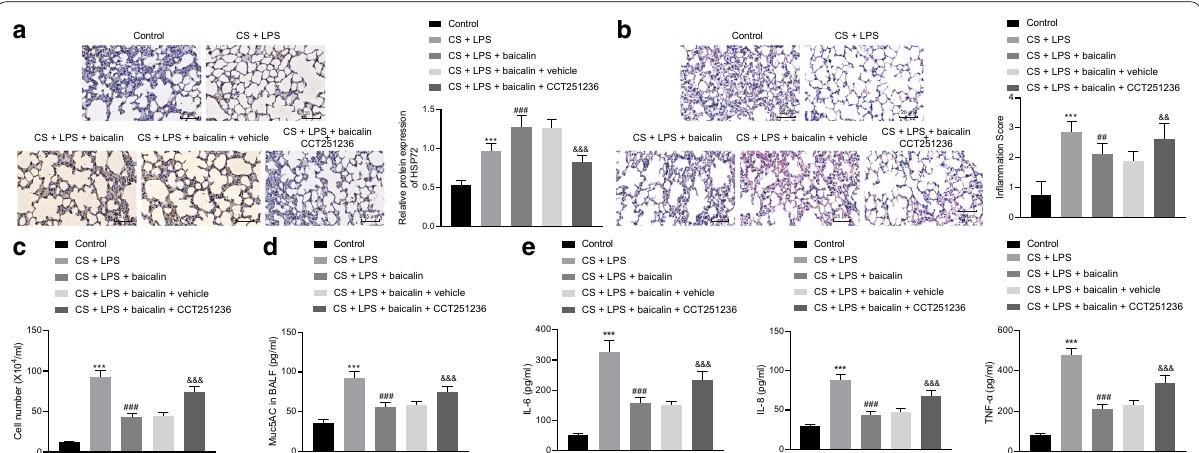
Fig. 4 The HSP72 inhibitor CCT251236 inhibited the therapeutic effect of baicalin on COPD in vivo. a HSP72 expression in the lung tissues of mice was tested by immunohistochemistry ( 400). b Lung injury was visualized by H&E staining ( 400) and lung injury was scored. c The white blood × × cells in the BALF were measured by ELISA. d Muc5AC expression in the BALF was determined. e Expression of IL-6, IL-8, TNF-α in the BALF was measured by ELISA. Compared with the control group, * p < 0.05, ** p < 0.01, *** p < 0.001; compared with the CS LPS group, # p < 0.05, ## p < 0.01, + ### p < 0.001; compared with the CS LPS baicalin vehicle group, & p < 0.05, && p < 0.01, &&& p < 0.001. All experiments were repeated for three times + + + independently and the data were represented as mean